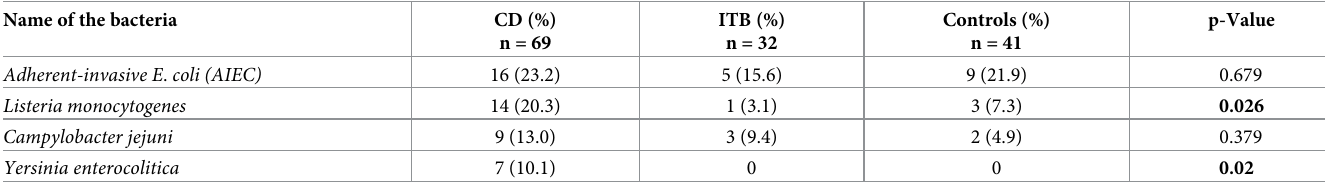
Table 2. Prevalence of bacteria isolated from biopsies of patients with CD, ITB and